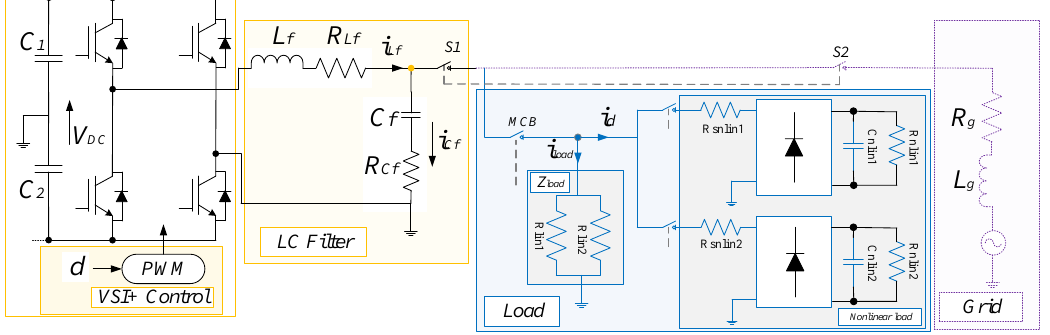
Figure 1. Distributed energy system